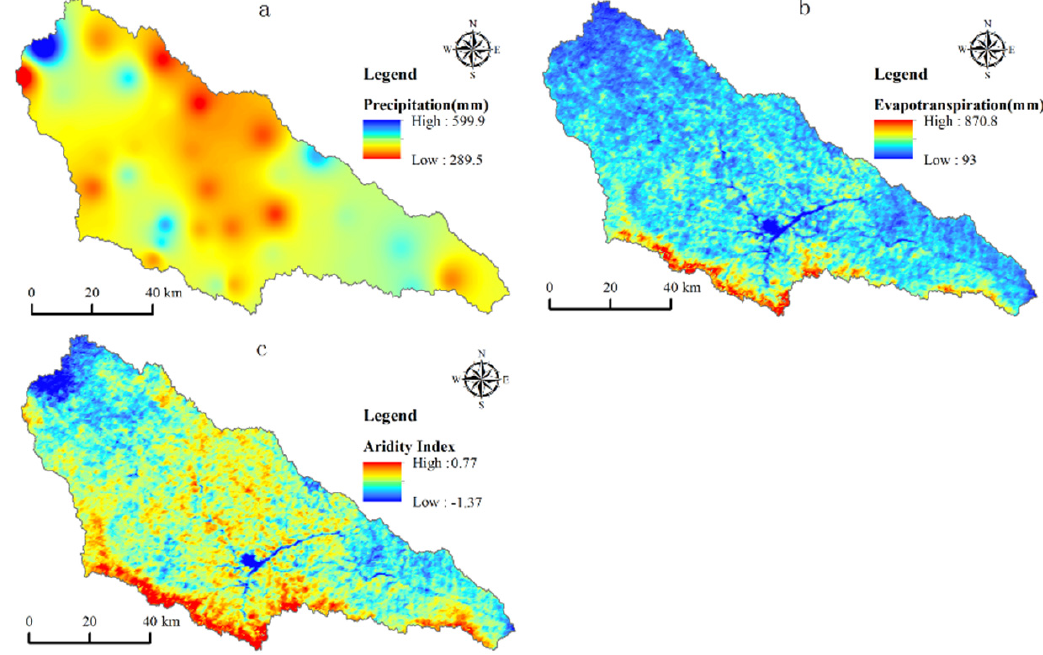
Figure 3. Spatial pattern of precipitation ( a ), evapotranspiration ( b ), and aridity index ( AI ) ( c ) in Yan River watershed in 2015.